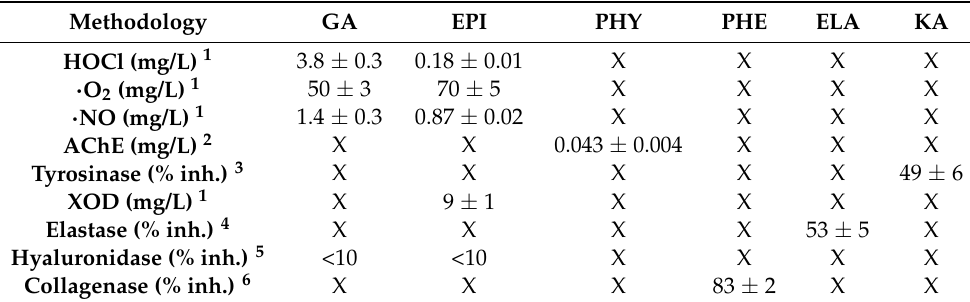
Table 4. Positive controls from radical scavenging and enzymatic inhibitions.